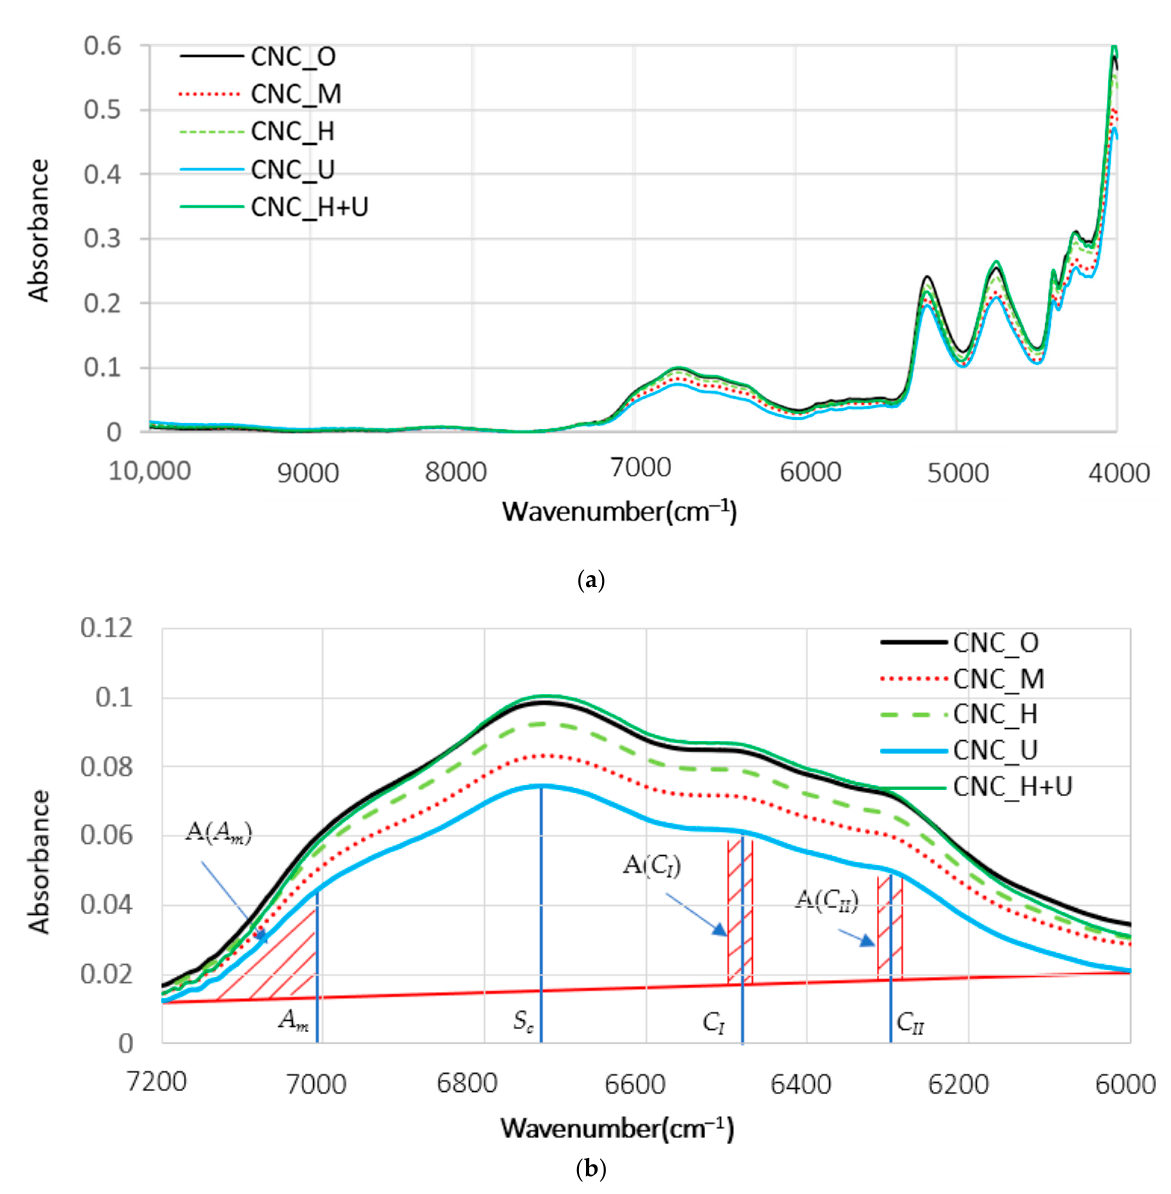
Figure 8. The original NIR spectra of the CNC films ( a ) the whole wavenumber range and ( b ) detail in the range of 7200–6000 cm − 1 .